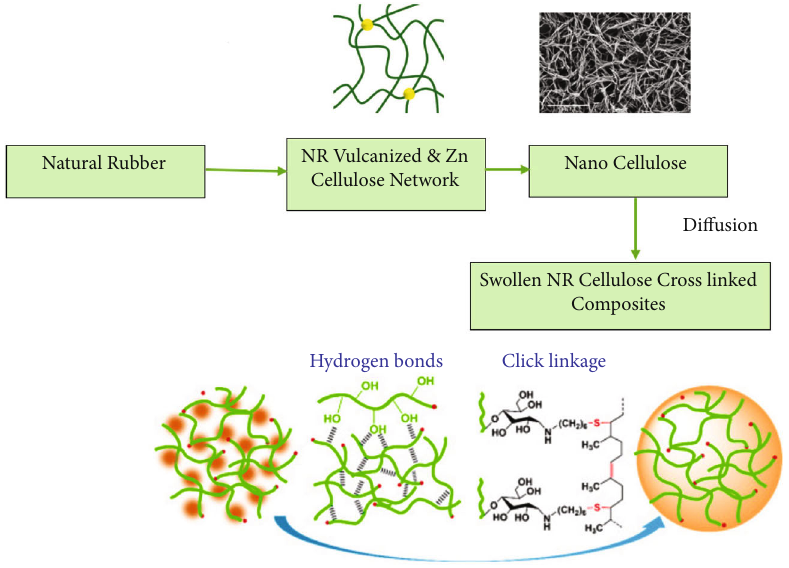
Figure 5: Illustration over the formation of dual network between rubber and ZnO.